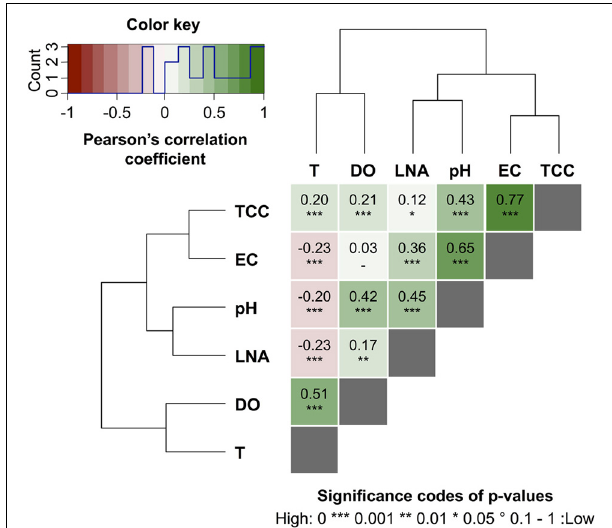
FIGURE 6 | Heat map of pair-wise Pearson’s correlation coefficients (PCC) computed between online FCM measurements, i.e., total cell concentration (TCC) and percentage of LNA content bacteria LNA, and the abiotic online sensor parameters, i.e., temperature (T), dissolved oxygen (DO), electric conductivity (EC), and pH in river water (Chriesbach, Dübendorf, Switzerland). Hierarchical clustering using the Ward’s algorithm was first applied to reorder all parameters in clusters according to their correlations as displayed by the dendrograms. The values and directions of the PCC are displayed according to the color key, i.e., positive correlations as green gradients from 0 to 1 and inverse correlations as red gradients from 0 to − 1. Baseline data for these correlations were calculated based on 4 weekdays (days 6–9, Table